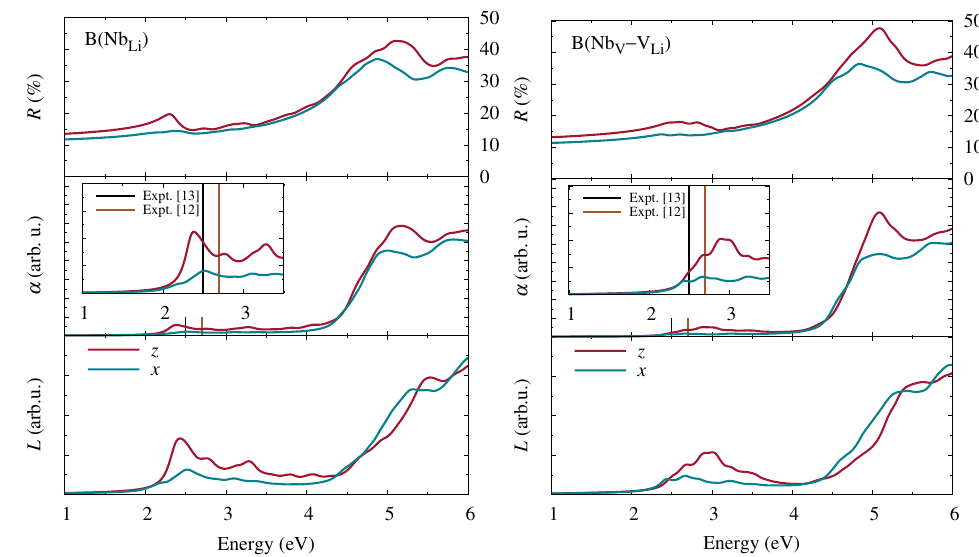
Figure 8. Optical properties derived from the dielectric function within the BSE: reflectivity R ( top ), absorption coefficient α ( middle ), and electron-energy-loss function L ( bottom ) for z -polarized (red) and x -polarized (blue) light. The left panels correspond to bipolarons at a Nb Li antisite defect, the right panels to bipolarons at a Nb V –V Li defect pair. In the plots of the absorption coefficients, vertical lines indicate the position of the absorption band assigned to bipolarons in different experi- ments